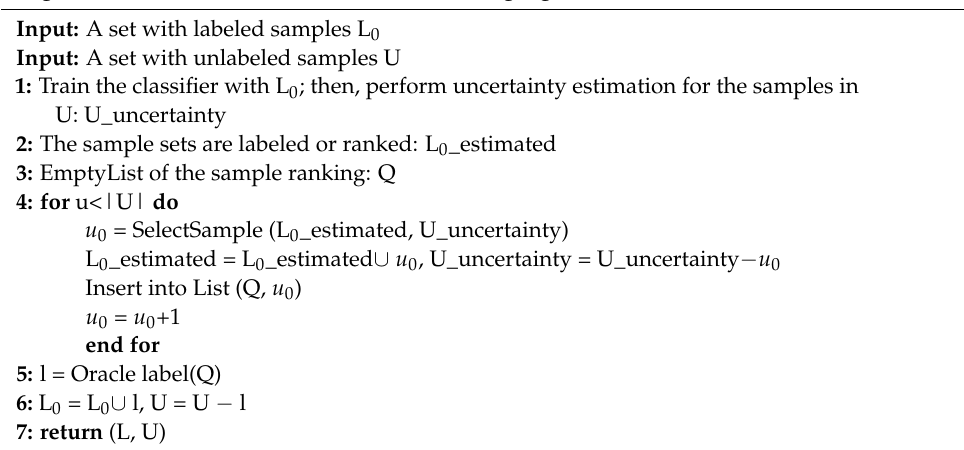
Algorithm 1: Ranked batch-mode active learning